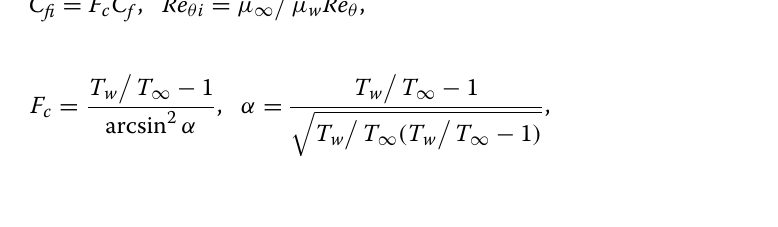
Table 3 Drag reduction rates with different control measures